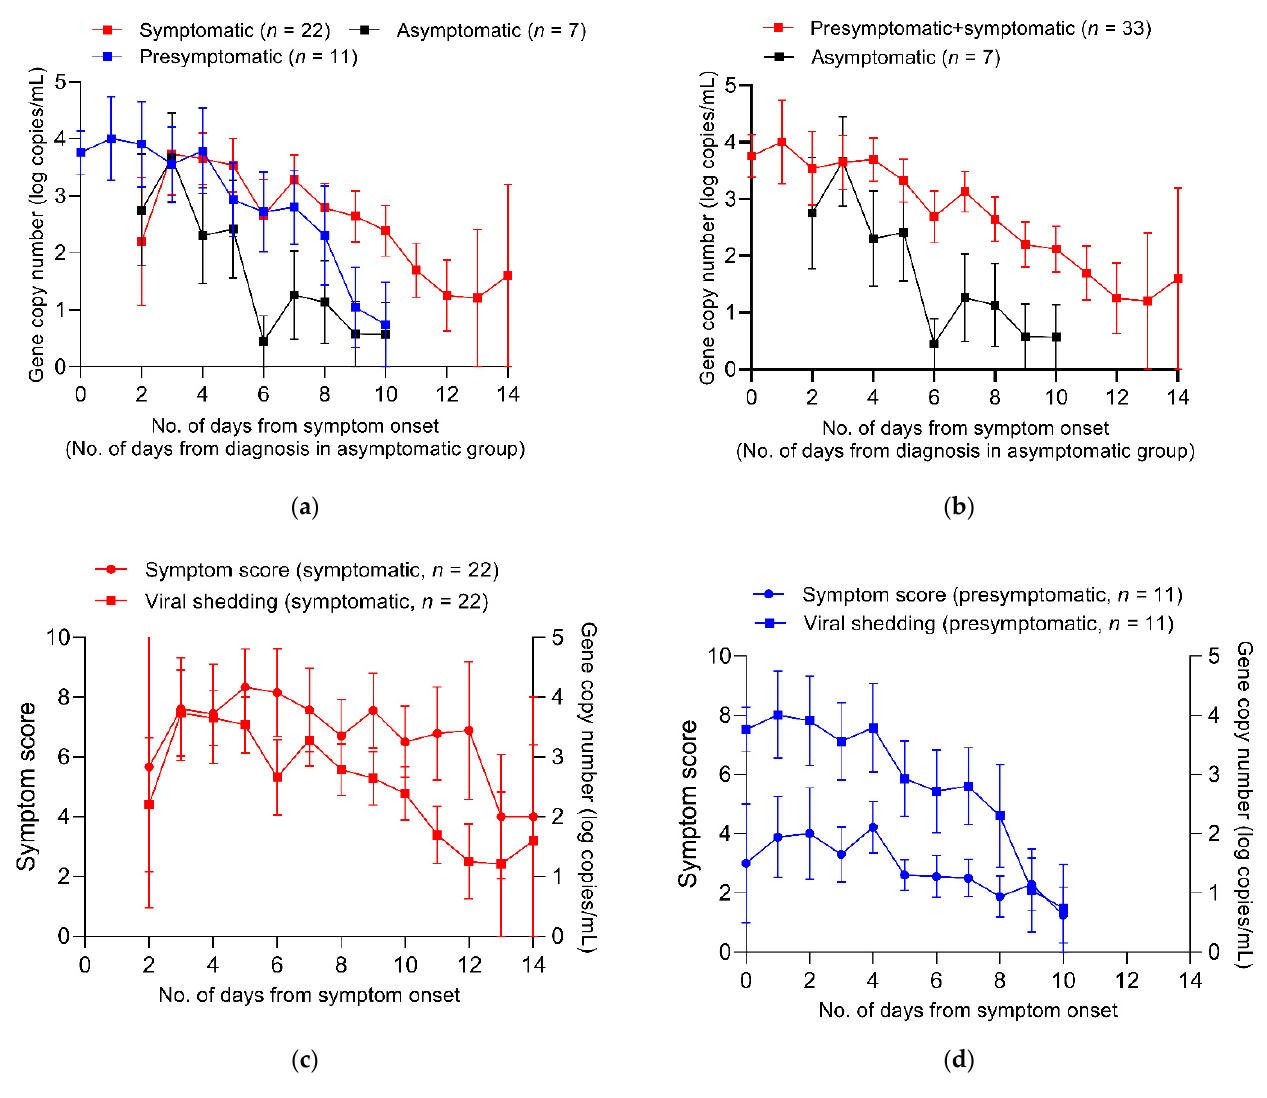
Figure 2. Summary curves of viral shedding and symptom score in patients. ( a ) Summary curves of viral shedding for symptomatic, presymptomatic and asymptomatic patients. ( b ) Summary curves of viral shedding for symptomatic + presymptomatic patients and asymptomatic patients. ( c ) Summary curves of symptoms core and viral shedding for symptomatic patients. ( d ) Summary curves of symptom score and viral shedding for presymptomatic patients.